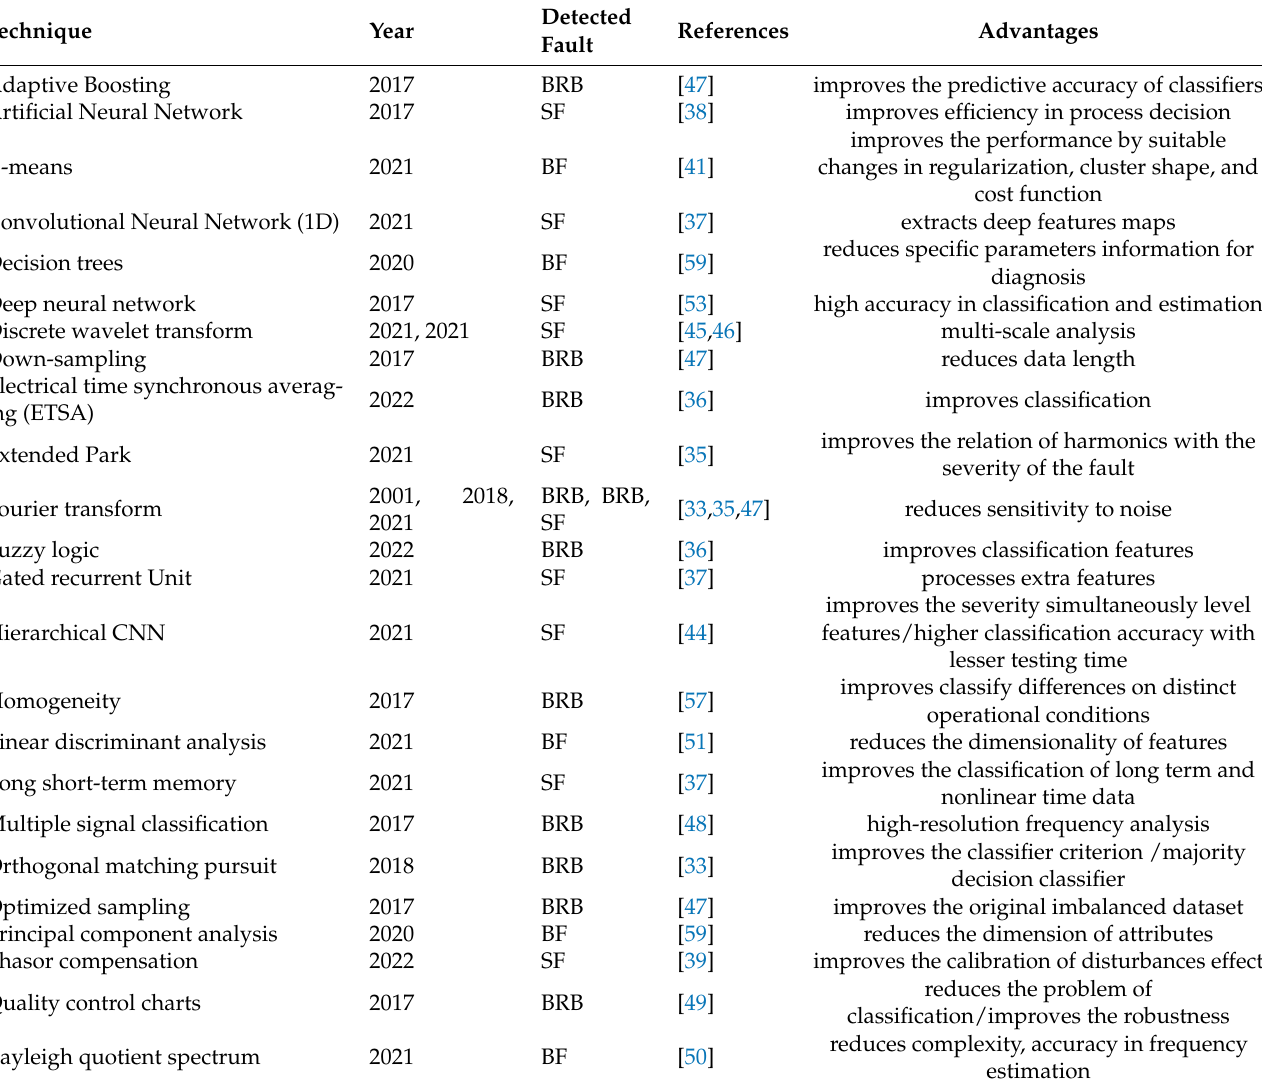
Table 4. List of the different applied